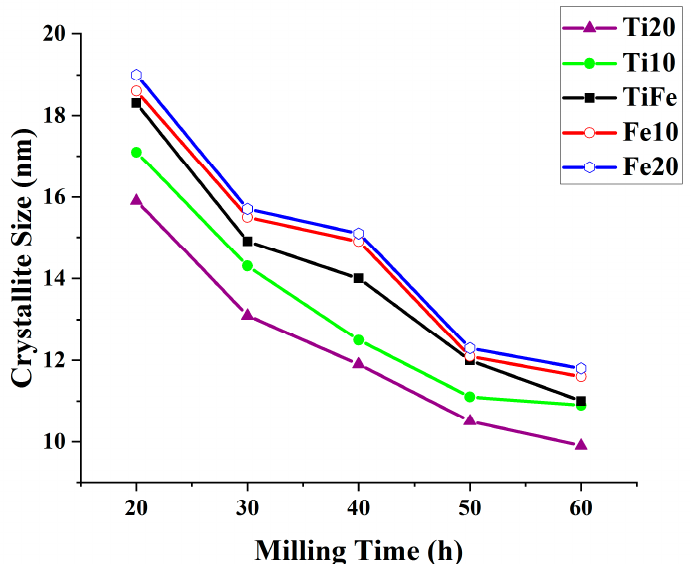
Figure 7. Crystallite size of TiFe-based crystal structure in TiFe, Ti10, Ti20, Fe10, and Fe20 milled products as a function of milling times.